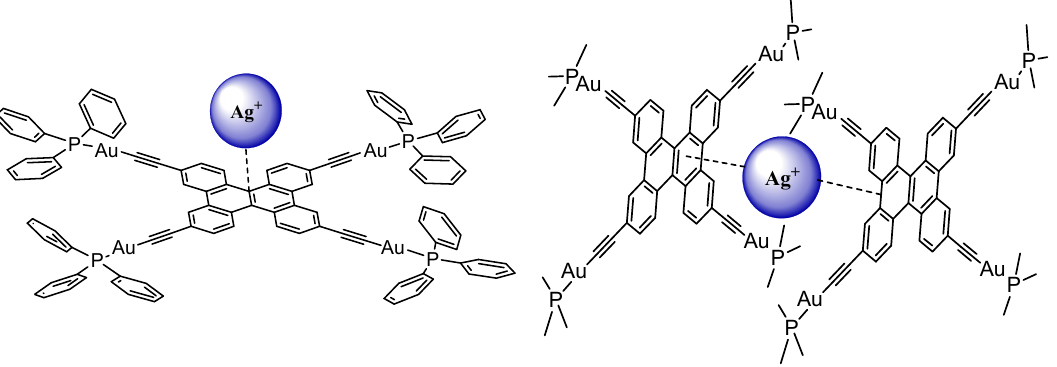
Figure 6. Schematic representation of the expected heterometallic complexes derived from 3 and 4 with AgOTf.